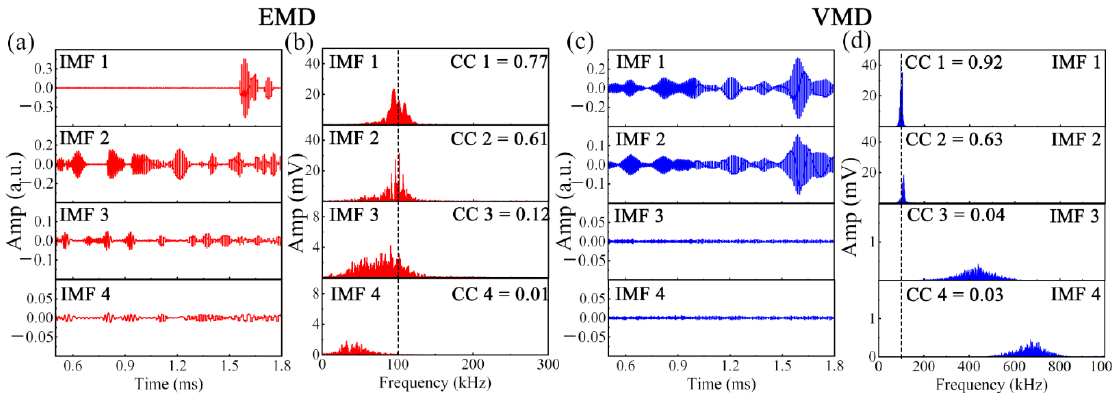
Figure 15. IMFs of EMD in the ( a ) time and ( b ) frequency domains; IMFs of VMD in the ( c ) time and ( d ) frequency domains.